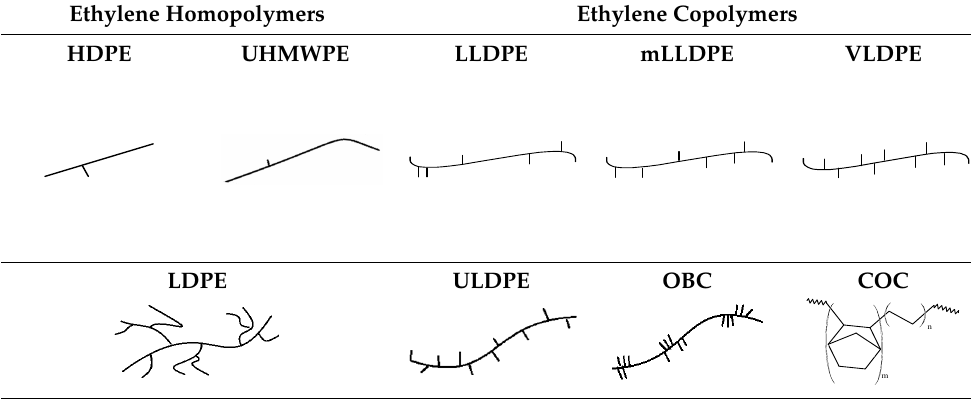
Table 2. Structures of main grades of polyethylene and ethylene copolymers.